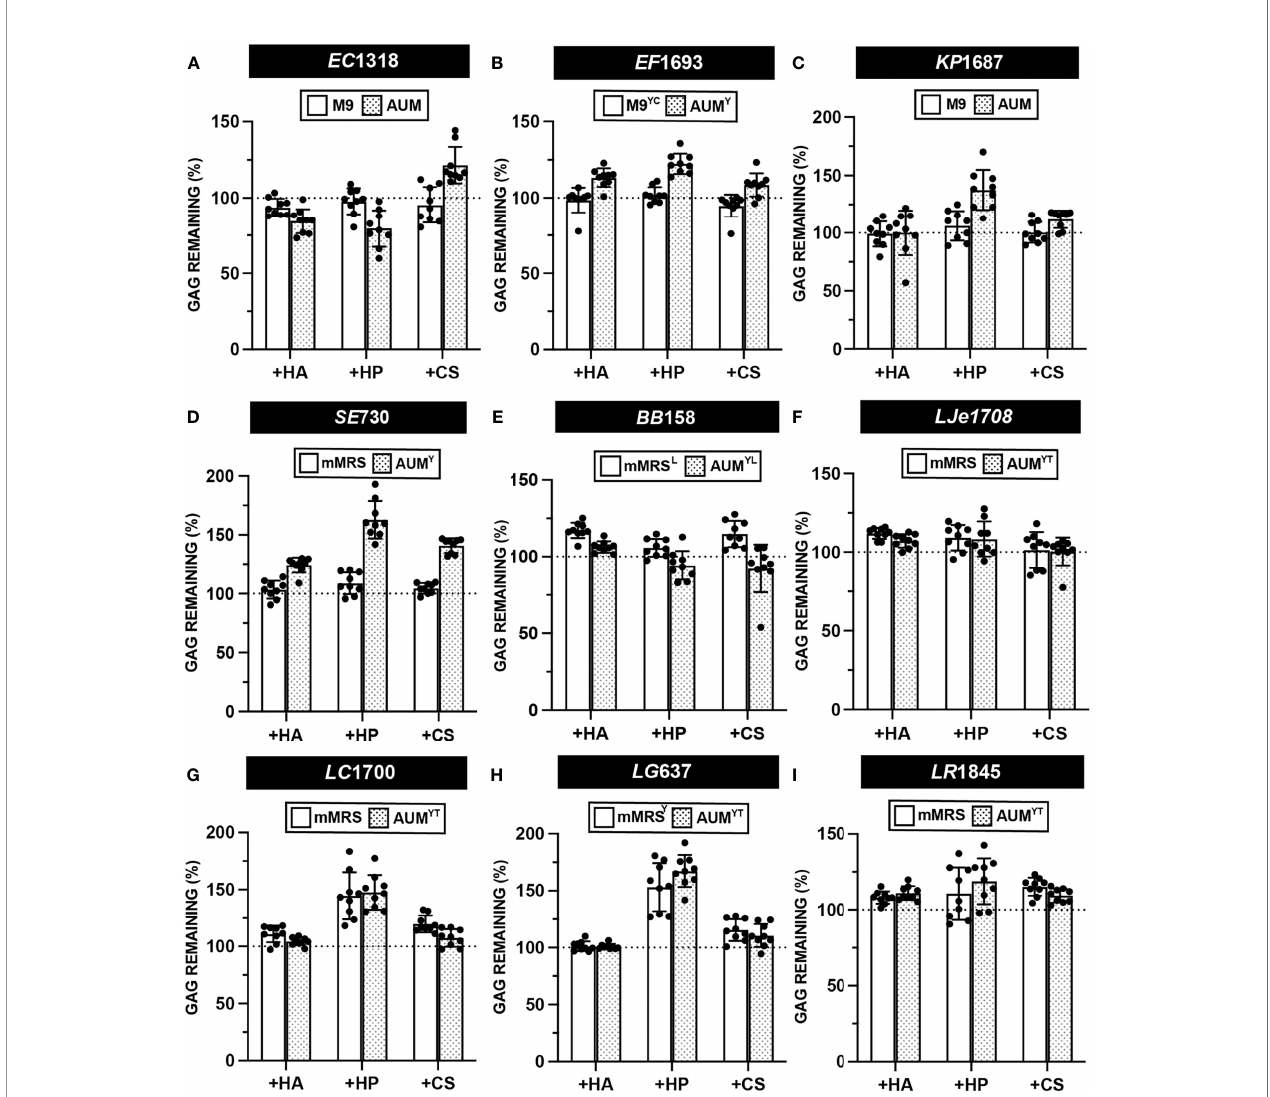
FIGURE 6 | Semi-quantitative GAG degradation by urinary bacteria. GAG degradation assays were performed on strains (A) E. coli EC1318 (B) E. faecalis EF1693 (C) K. pneumoniae KP1687 (D) S. epidermidis SE730 (E) B. breve BB158 (F) L. jensenii LJe1708 (G) L. crispatus LC1700 (H) L. gasseri LG637 (I) L. rhamnosus LR1845 post-incubation with supplemented basal or AUM media and percent GAG remaining was determined using the semi-quantitative formula. Points represent values across three biological replicates and three technical replicates and error bars represent standard deviation from the mean. Dotted line represents a 100% theoretical threshold signifying no GAG